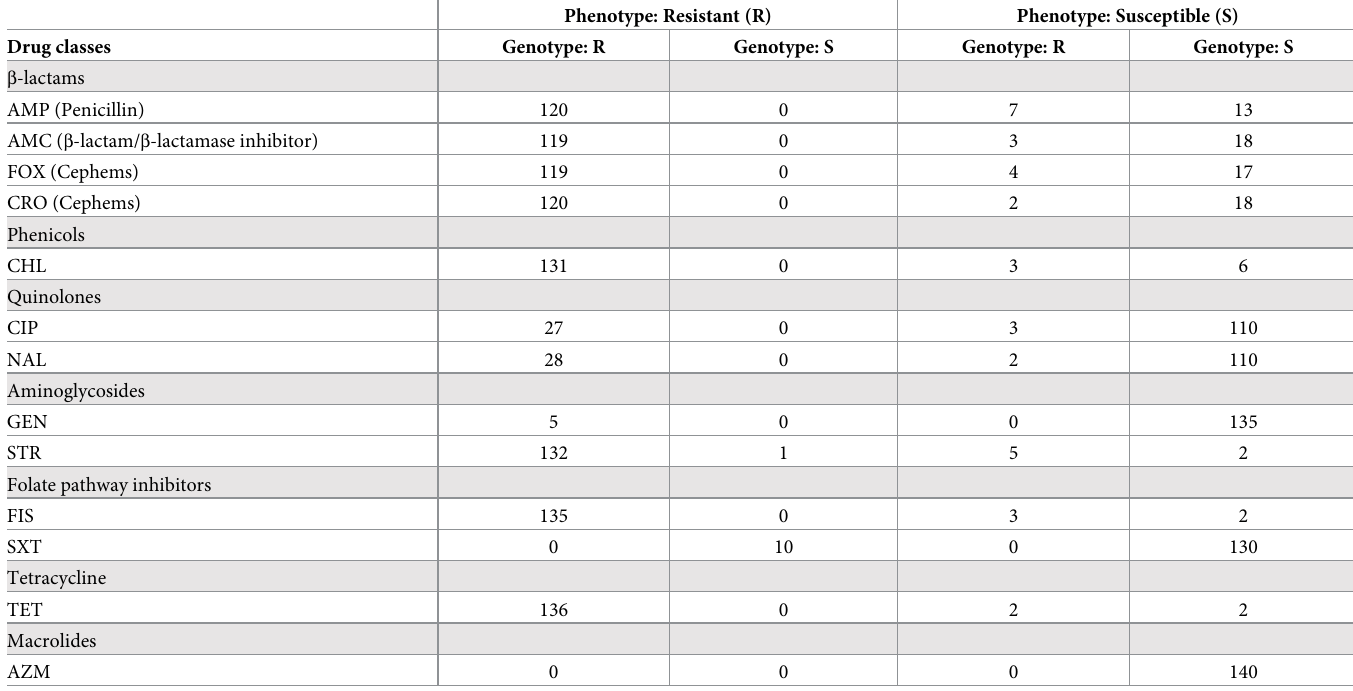
Table 3. Relationship of antimicrobial susceptibility with antimicrobial resistance